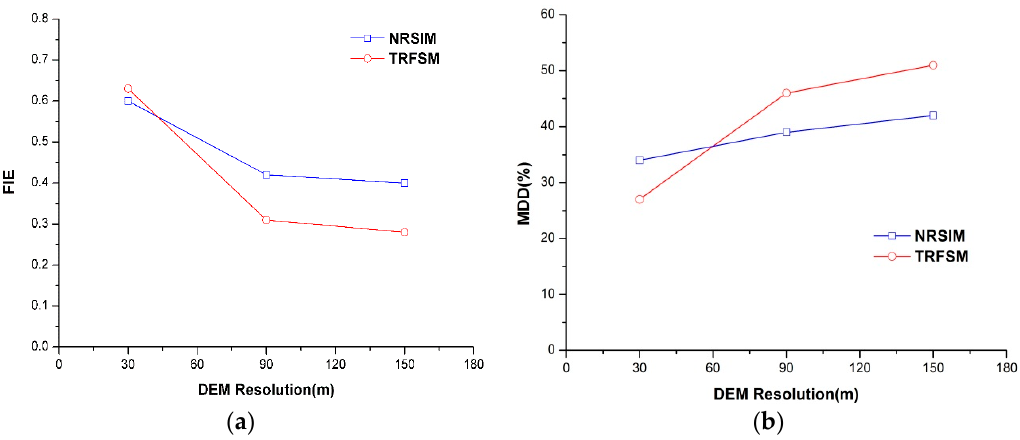
Figure 14. Comparison of fit indicator ( a ); and mean depth deviation (MMD) ( b ) between NRSIM and TRFSM by using different resolution DEMs.